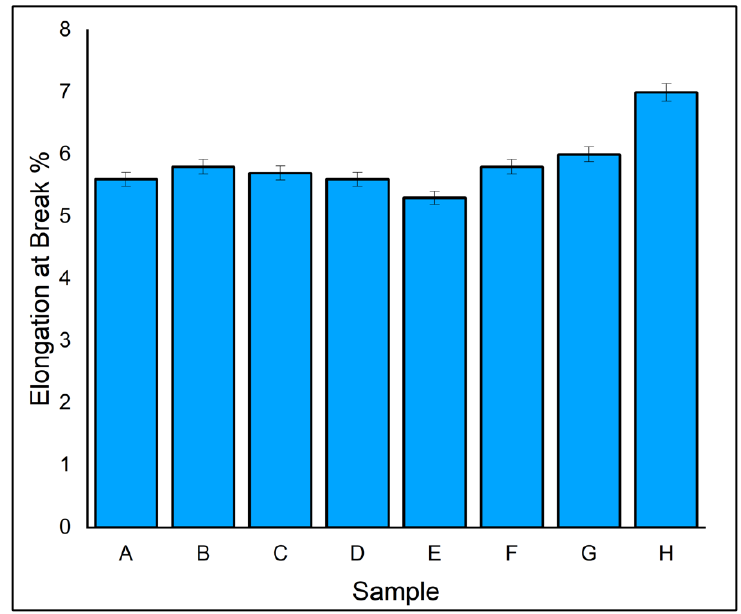
Figure 7. Elongation of break (%) of composite.